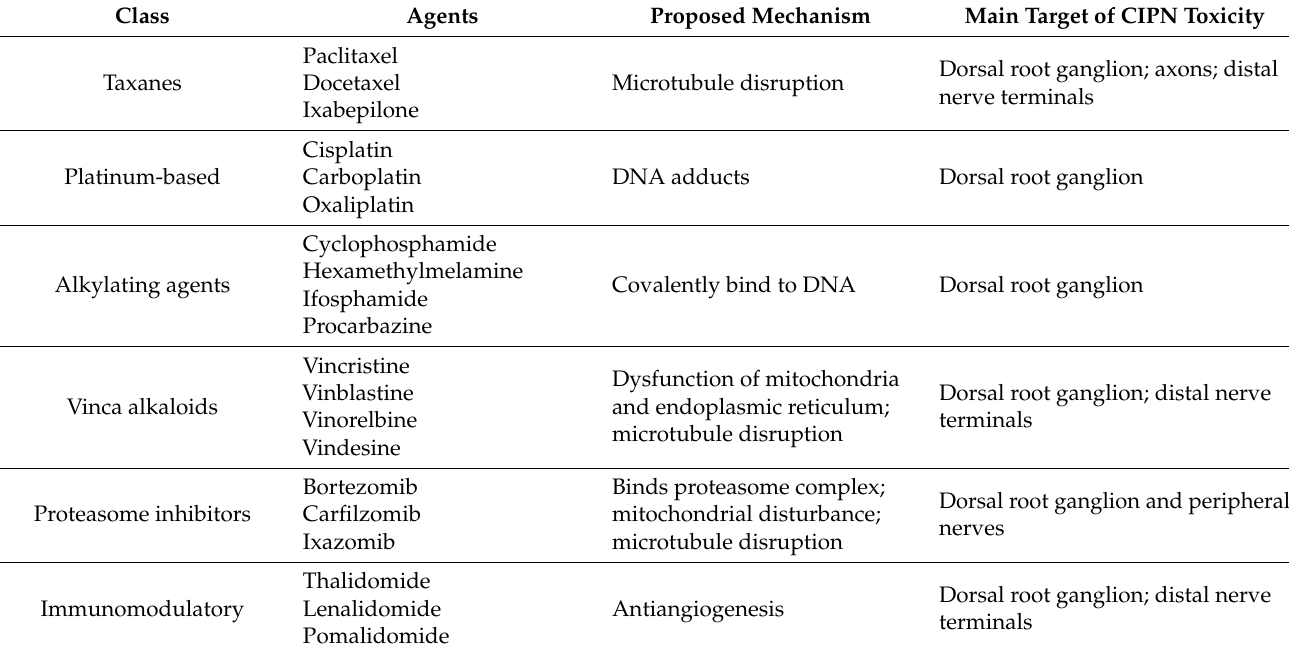
Table 1. Anticancer agents known to cause CIPN and their proposed mechanisms and target sites of CIPN toxicity [1–5,7–9,23–25]. Class Agents Proposed Mechanism Main Target of CIPN